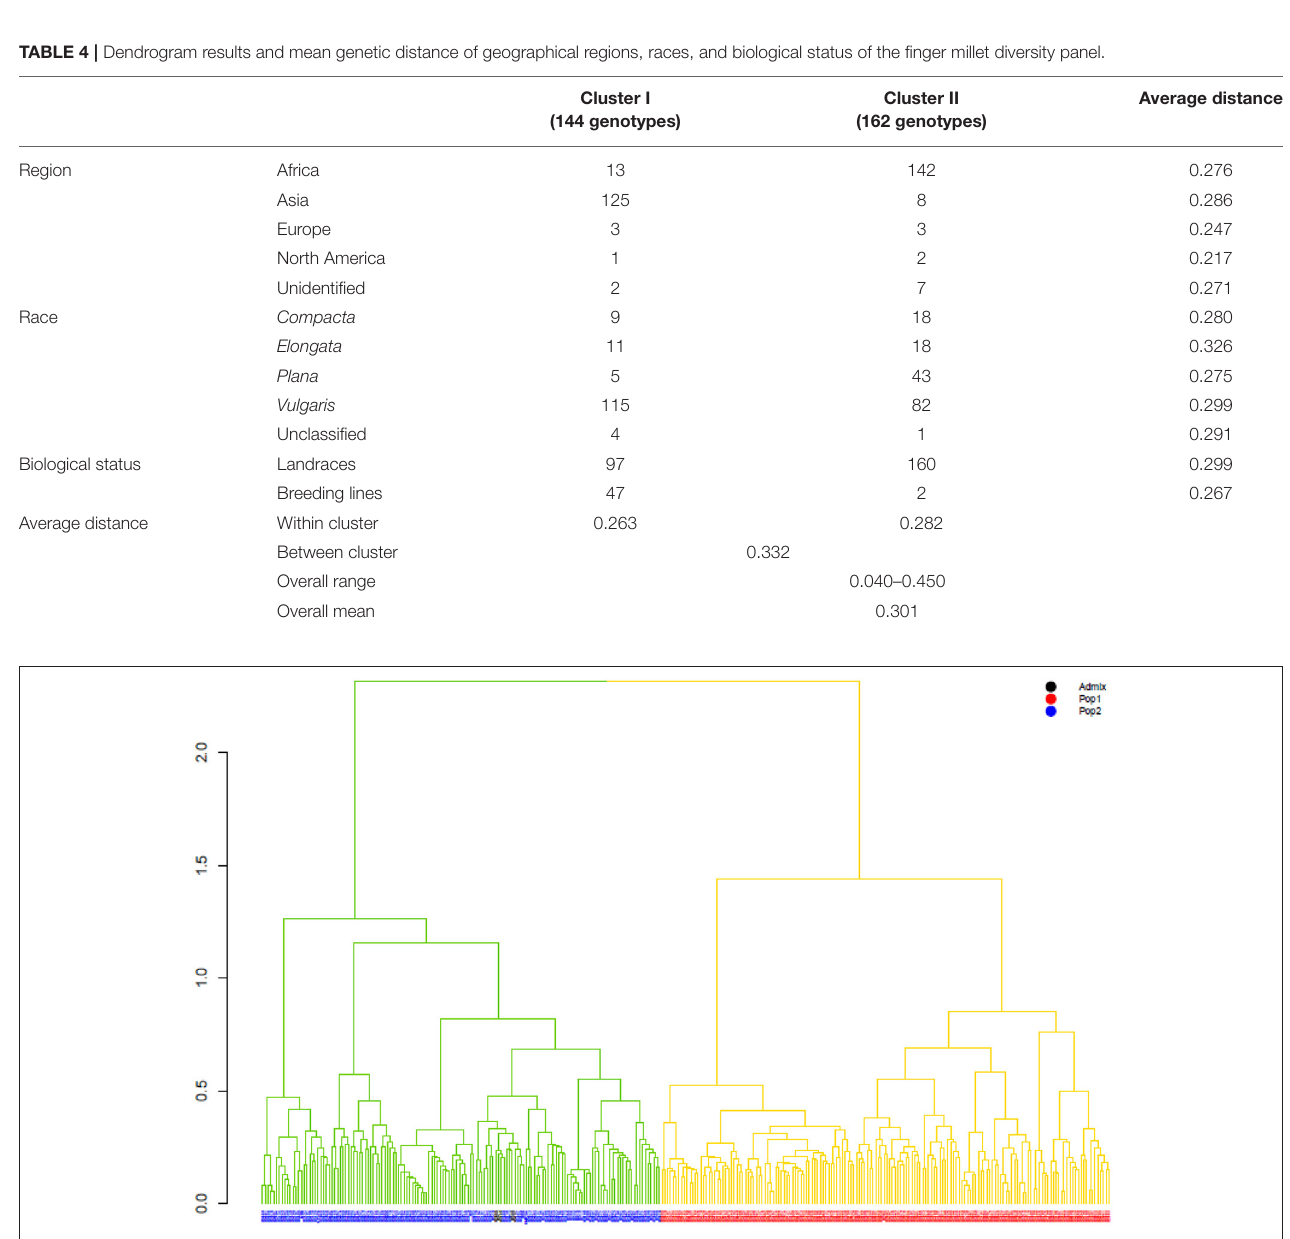
FIGURE 3 | The ward.D2 agglomerative hierarchical clustering analysis of finger millet diversity panel, using DArTseq-based modified Roger’s distance. Note: colored branches: cluster I – Asia (green); cluster II – Africa (yellow); colored accessions-subclustering based on STRUCTURE